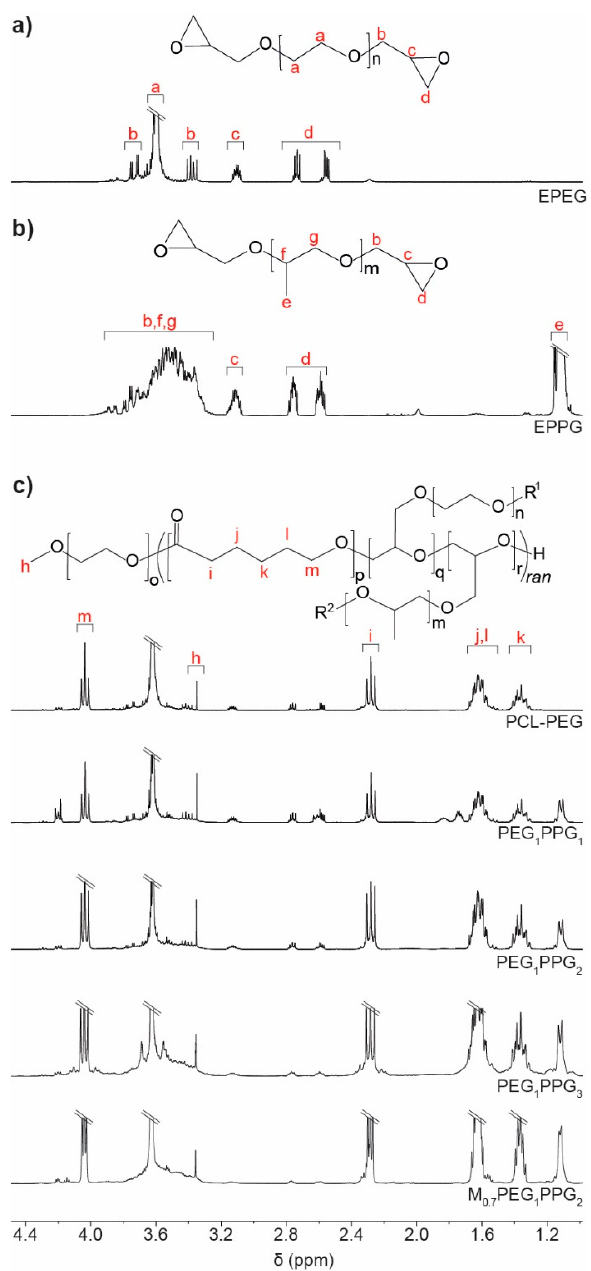
Figure 1. 1 H NMR spectra (CDCl 3 ) of the macromonomers ( a ) EPEG and ( b ) EPPG, and ( c ) PCL–PEG and PCL–PEG–PPG copolymers: PEG x PPG y , where x and y , represent the mole ratio of the EPEG and EPPG macromonomers used in their synthesis.